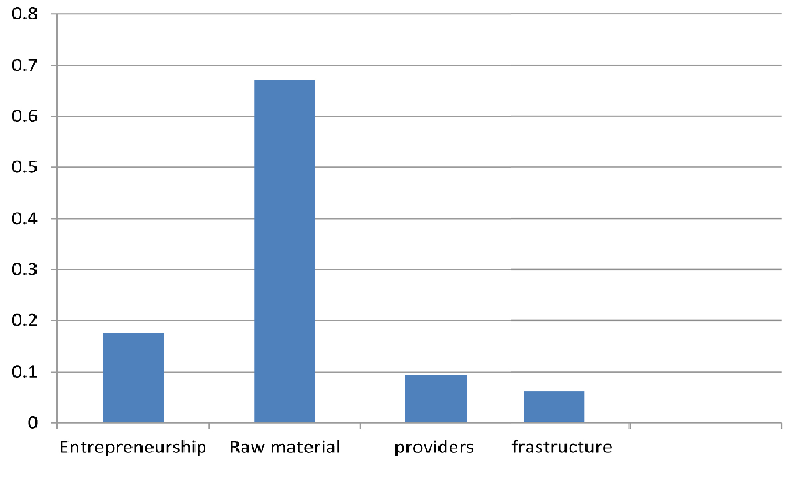
Figure 3: The priority of benefits in first level (inconsistency rate 0.05), X: Criteria, Y: Weighing value